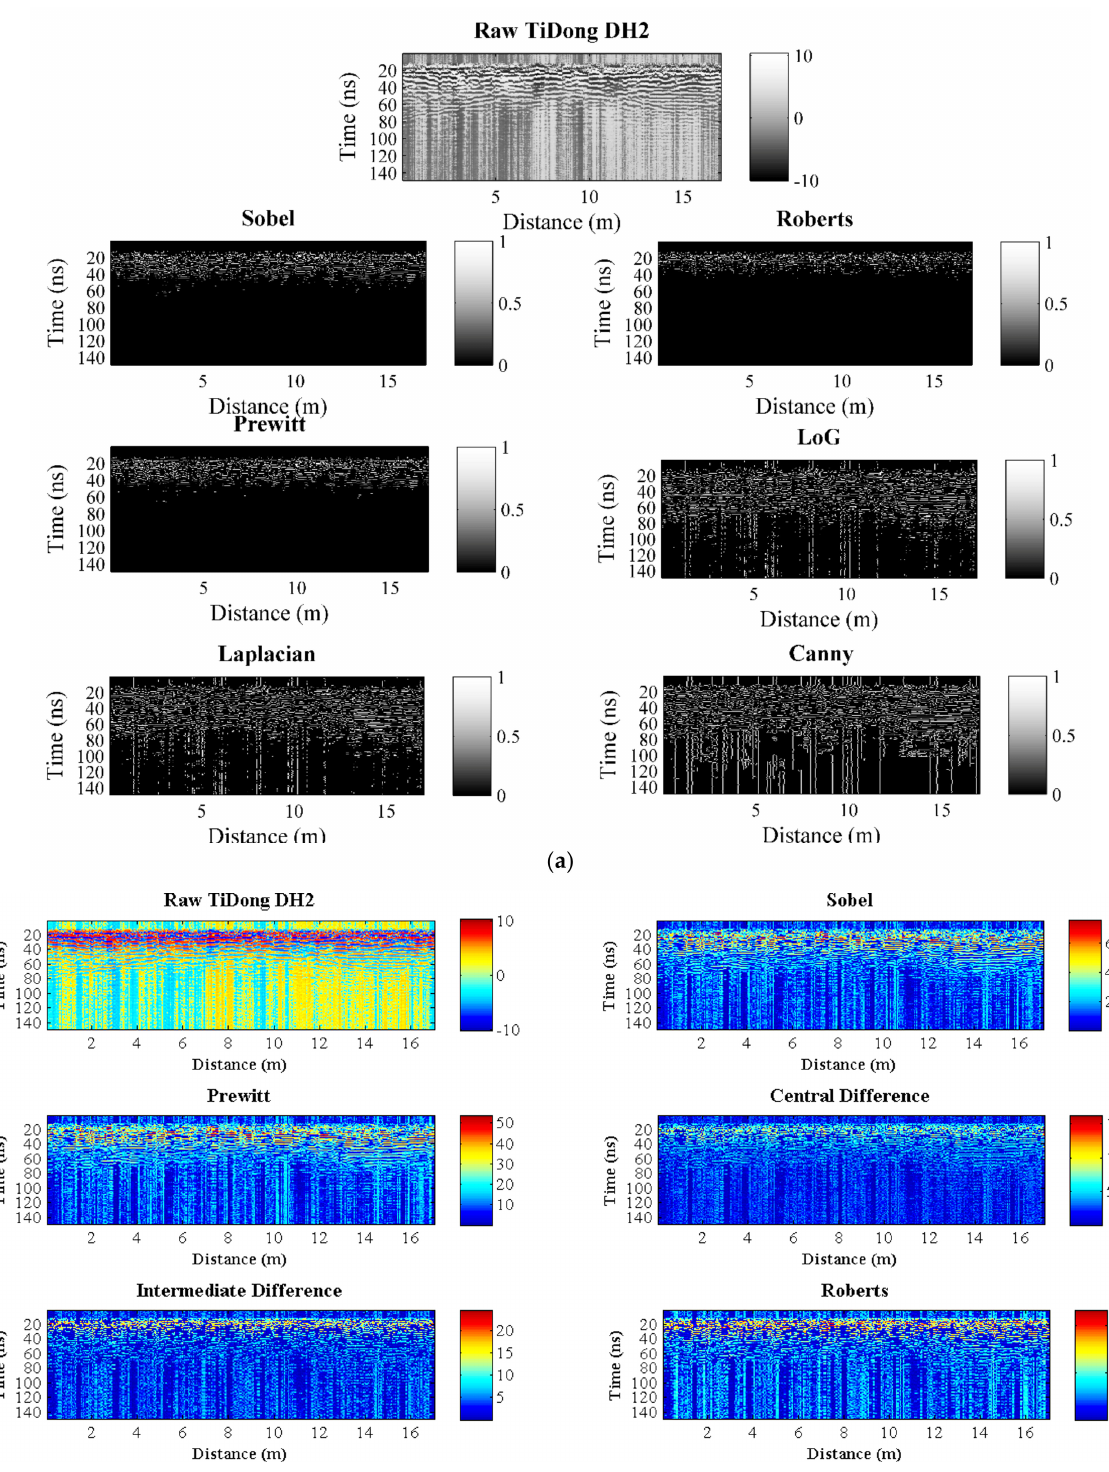
Figure 10. Original GPR reflection profile and the results processed by using various edge detectors without MDEEMD. ( a ) Binary edge maps. ( b ) Two-dimensional edge maps. The data were acquired over the site shown in Figure 9, where a hot spring well was buried. The symmetric hyperbolic diffraction event shown at 50 ns to 80 ns across the entire profile indicates the surface scattering from a nearby tree. The black and white color palette is selected to increase the visual resolution in ( a